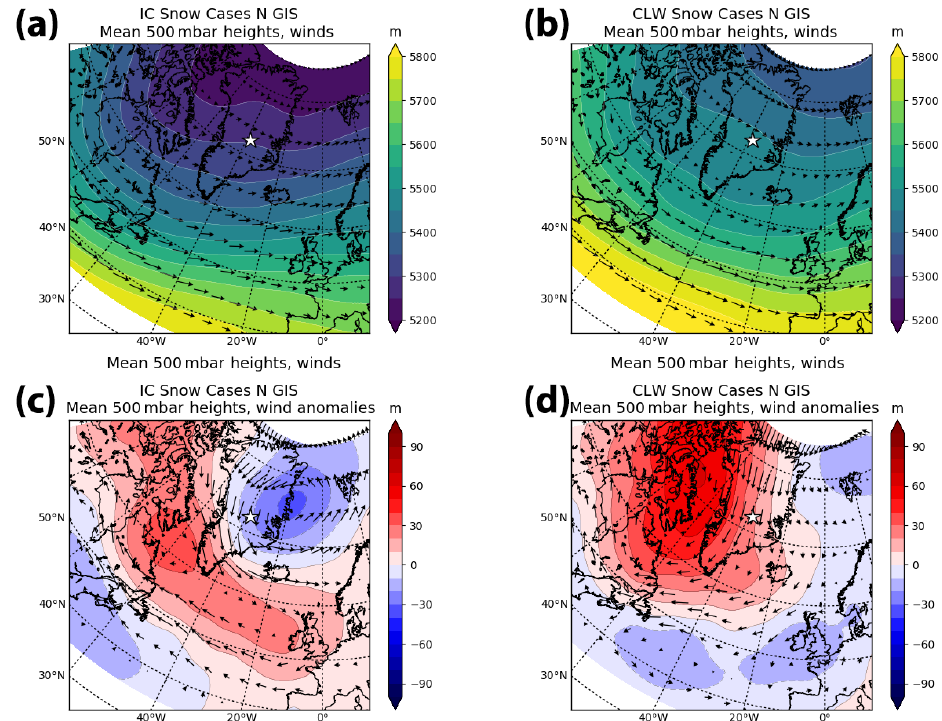
Figure 15. As in Fig. 14 but for the northern GrIS: basins 1.1, 1.2, 1.3, and 1.4.